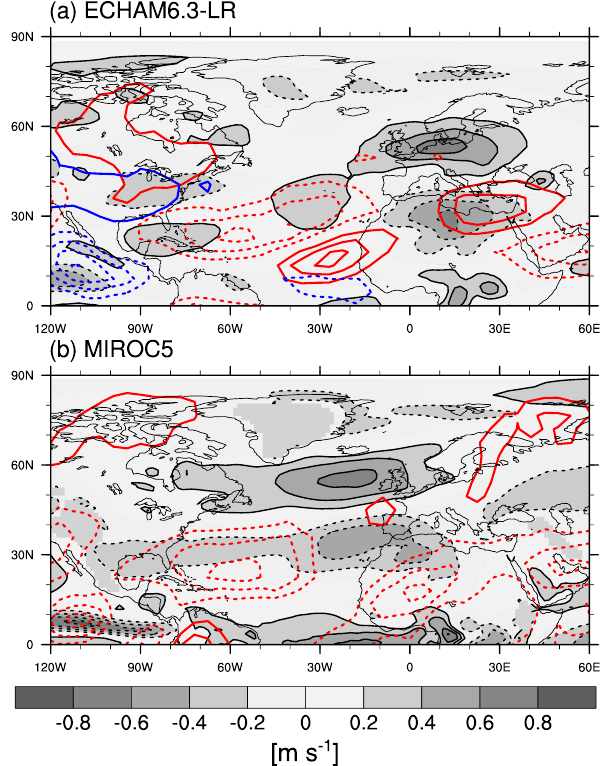
Figure 8. DJF ensemble mean responses (future minus present) of the Rossby wave frequency and 850hPa zonal wind for (a) ECHAM6.3-LR and (b) MIROC5. Blue (red) contours show the responses for the (anti)cyclonic wave breaking frequency (first con- tour and interval: 0.005d − 1 ). The grey shading and black contours show the response of the 850hPa zonal wind (in ms − 1 ). The zero contours are omitted, and dashed contours represent negative val-